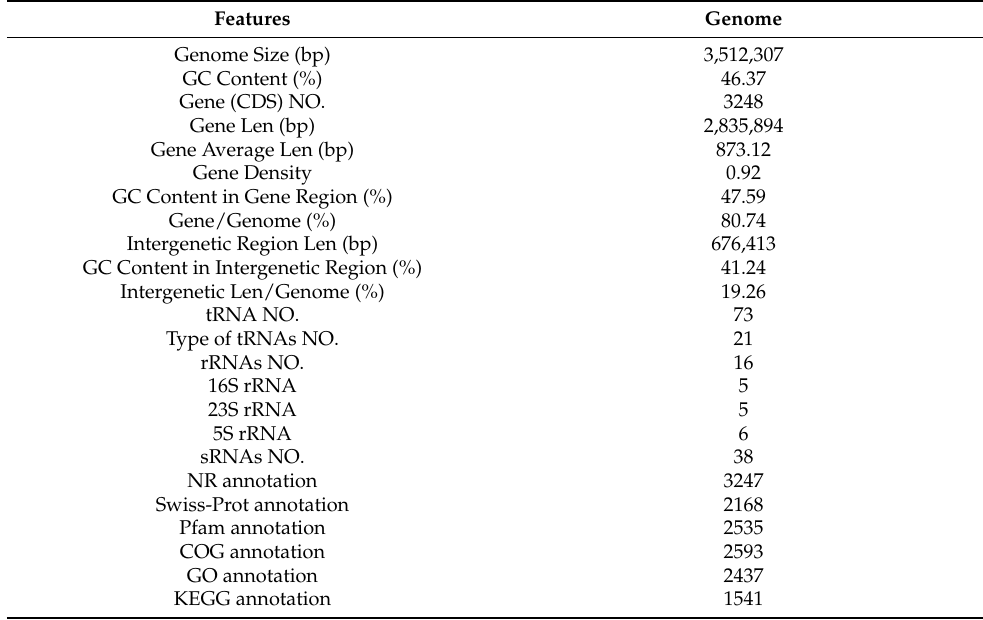
Figure 3. The whole genome of L. pentosus LTJ12. ( A ) Chromosome. ( B ) Plasmid 1. ( C ) Plasmid 2. ( D ) Plasmid 3. The genome map is composed of seven circles. From the outer circle to inner circle, each circle displays information regarding the genome of (1) forward COG function classification, (2) forward CDS, tRNA, rRNA, (3) reverse CDS, tRNA, rRNA, (4) reverse COG function classification, (5) G + C content, (6) GC skew and (7) the genome size identifier. Table 2. Genome features of L. pentosus LTJ12.